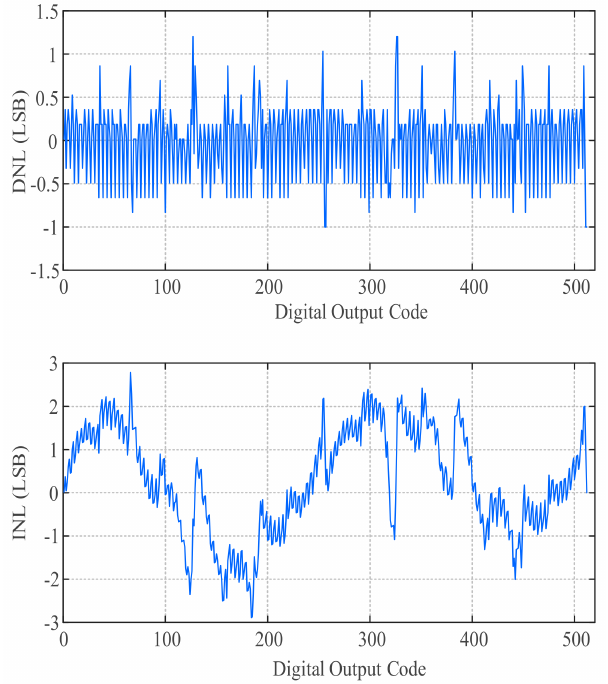
Figure 10. Post-simulated DNL and INL.